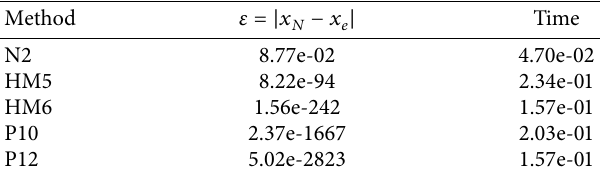
Table 4: Comparison of several methods with the same number of iterations ( N � 5 ) while the initial guess is set to be F ( x Problem